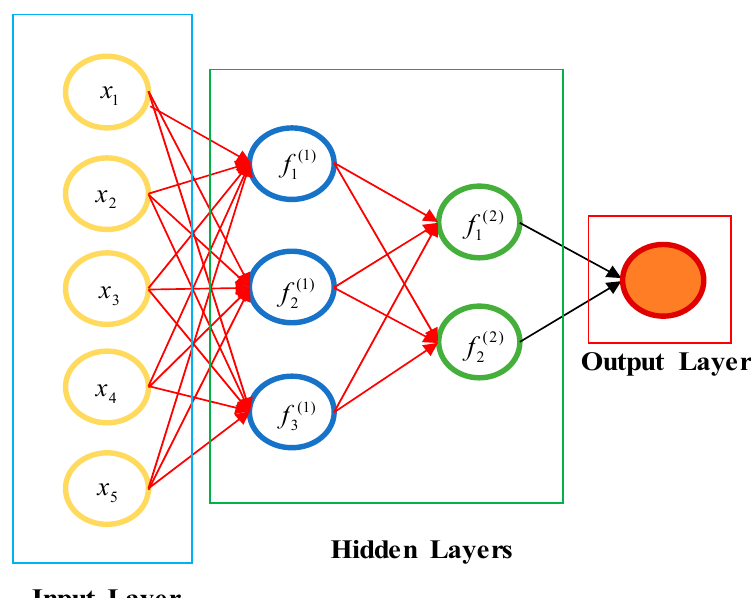
Figure 3. Schematic diagram of a deep neural network with multiple hidden layers .